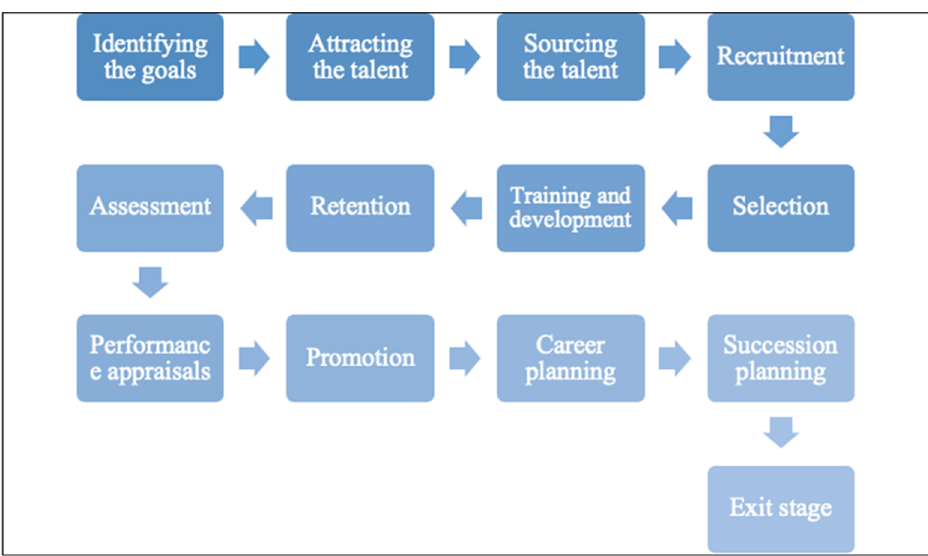
Figure 1. Talent management process. Adapted from Andreev Ivan, 2021 .